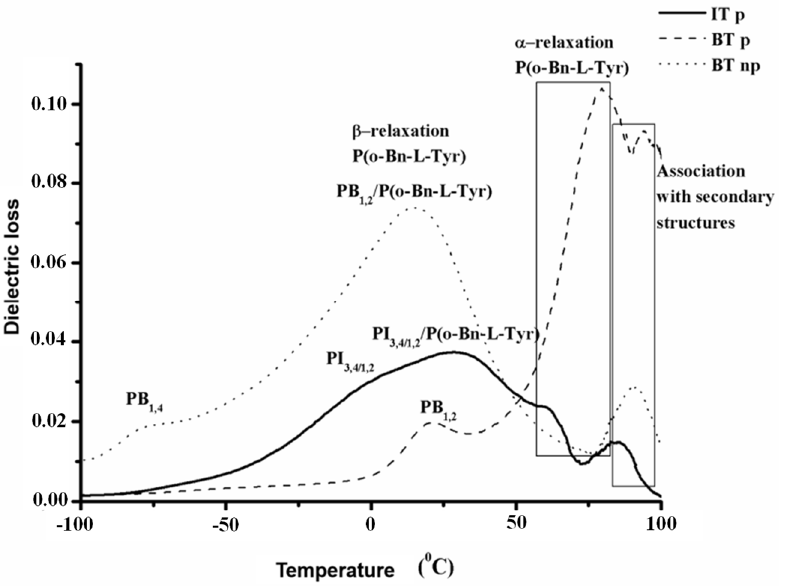
Figure 8. DS spectra of modulus vs. temperature for samples PI 1,4 - b -P(o-Bn-L-Tyr) (solid line), PB 1,4 - b -P(o-Bn-L-Tyr) (dotted line) and PB 1,2 - b -P(o-Bn-L-Tyr) (dashed line), respectively. For the PB 1,4 - b -P(o-Bn-L-Tyr) (dotted line), the intermediate process took place at 15 ◦ C. The PI 3,4/1,2 - b -P(o-Bn-L-Tyr) (solid line) showcased the process at 28 ◦ C and the PB 1,2 - b -P(o-Bn-L-Tyr) (dashed line) at 21 ◦ C, which may be attributed to the